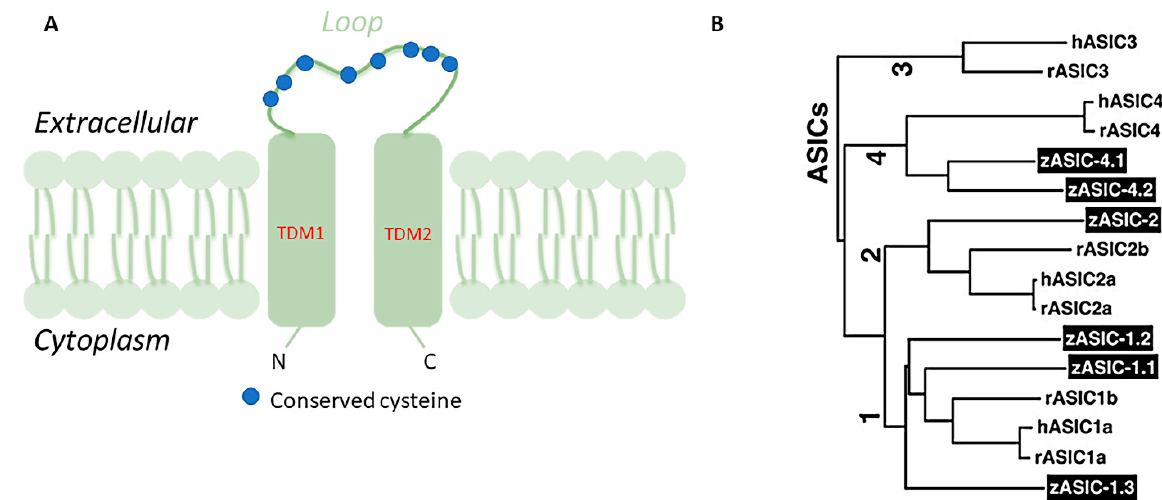
Figure 1. ( A ) Schematic view of one ASIC subunit: Each subunit has two hydrophobic transmembrane domains, a large cysteine-rich extracellular loop, and short intracellular N- and C- termini; ( B ) phylogenetic tree illustrating the relationship of zASICs and other ASICs from human (h) and rat (r) (Paukert et al., 2004 modified).